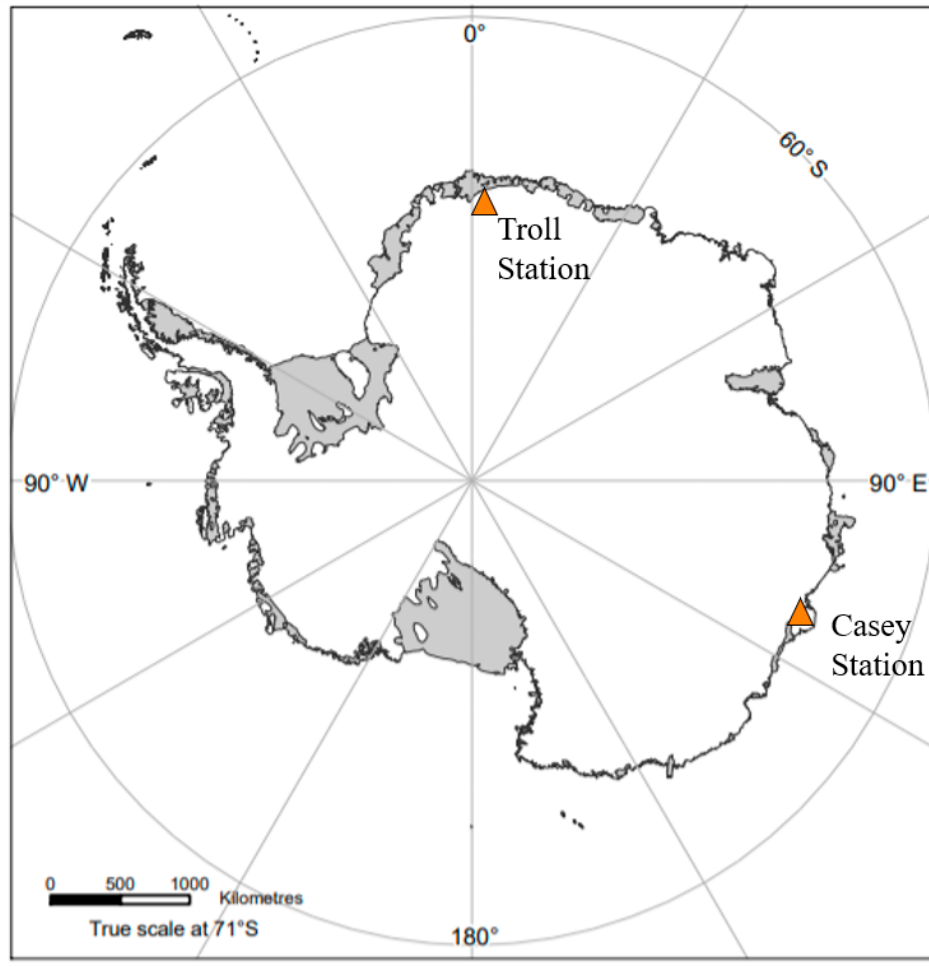
Figure 1. Antarctic air sampling locations in the current study.